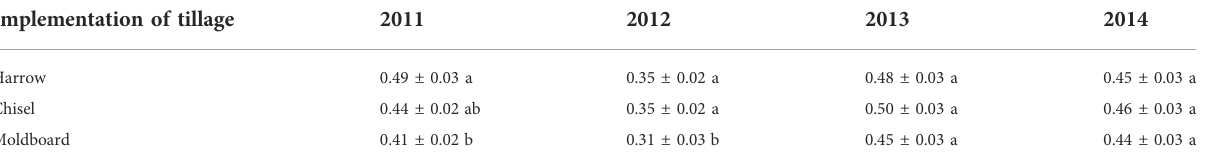
TABLE 9 Stock carbon indicator valued with tillage implement in an Oxisol of the Meta High